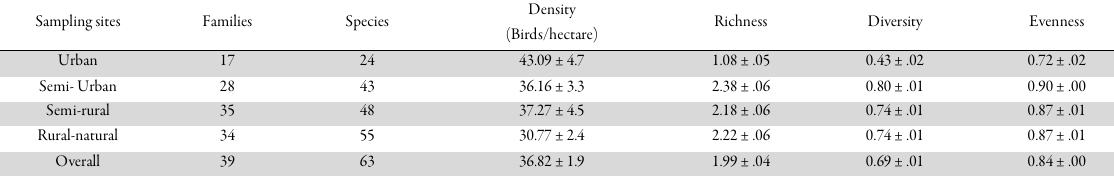
Table 3. Frequency of sighting of bird species at various urban gradient sites in Aligarh, Uttar Pradesh, India Species Urban Semi urban